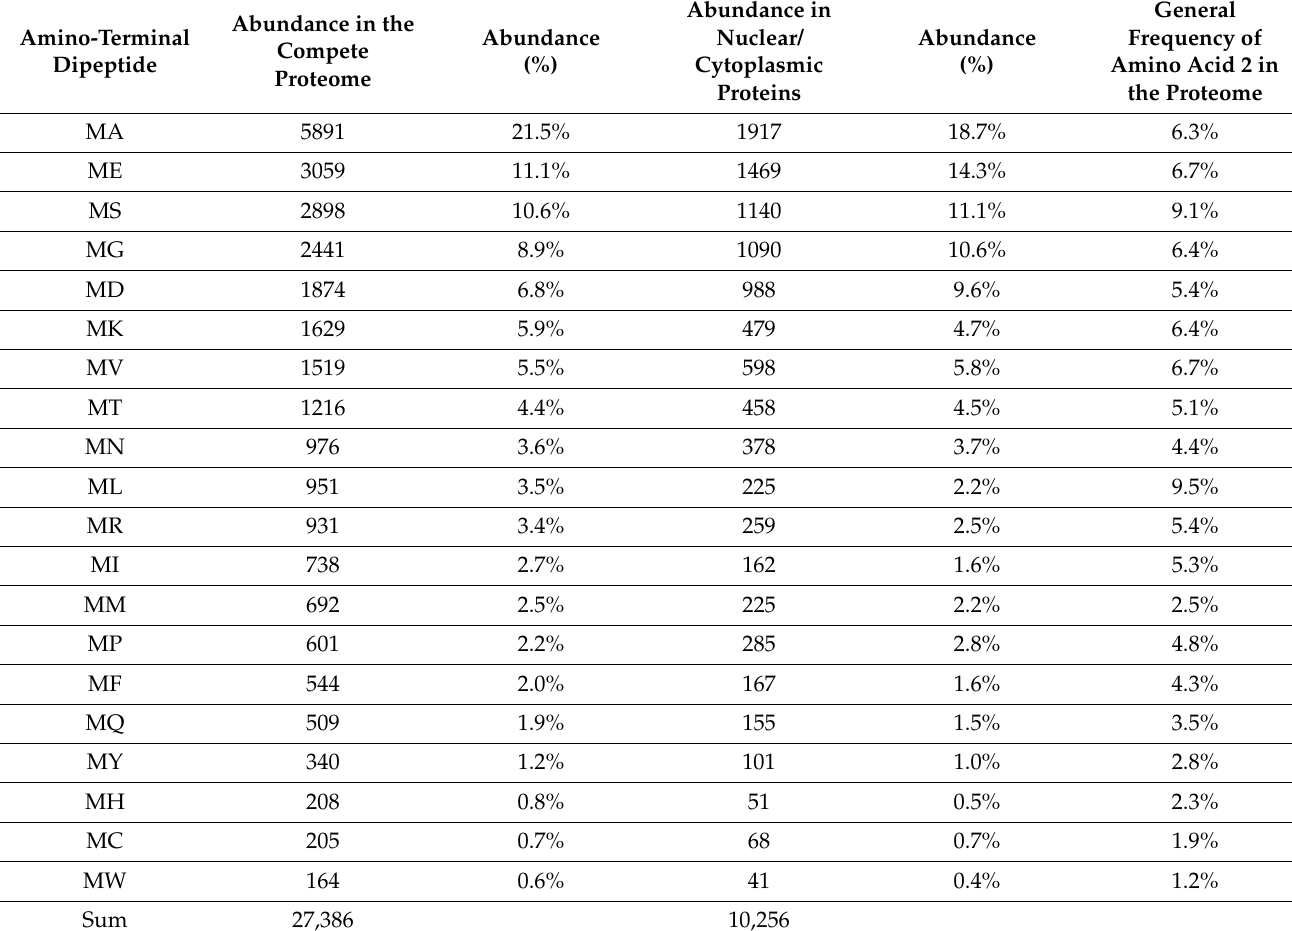
Table 2. Abundance of amino termini in the predicted proteome of Arabidopsis 1